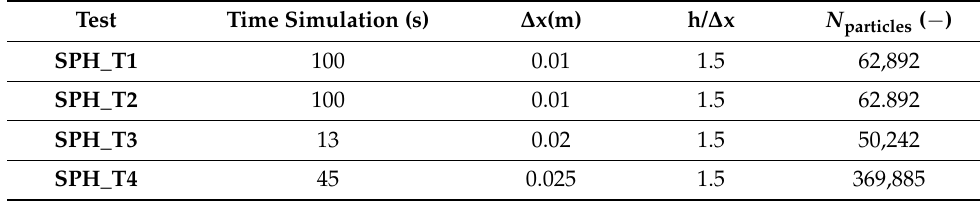
Table 2. Main characteristics of the SPH